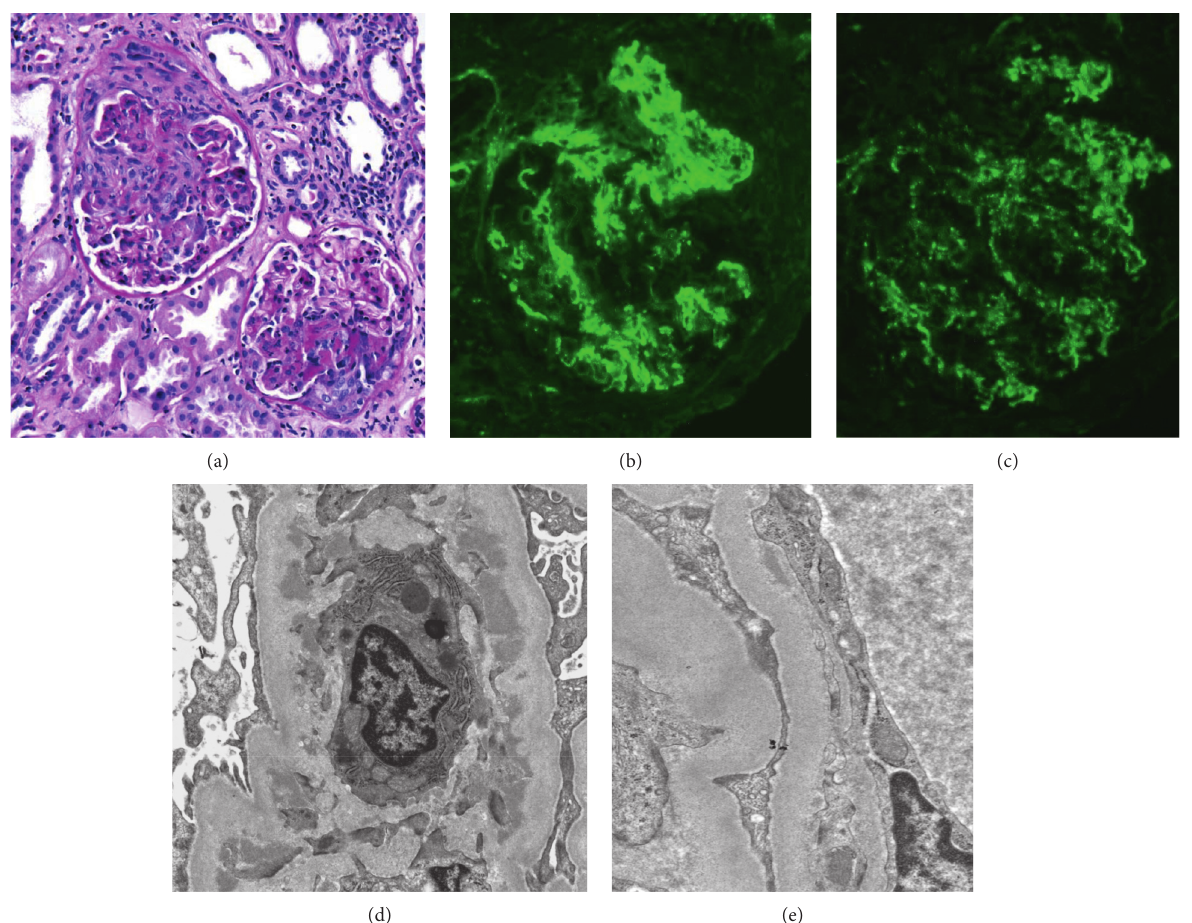
Figure 1: Kidney biopsy images. (a) Glomeruli with cellular crescents, one of which also shows segmental necrosis (arrow). Periodic-acid Schiff. (b) Strong granular mesangial staining for C3 by immunofluorescence. (c) Weak granular mesangial staining for IgG by im- munofluorescence. (d) Electron microscopy showing mesangial deposits (arrows) and (e) small subendothelial deposit